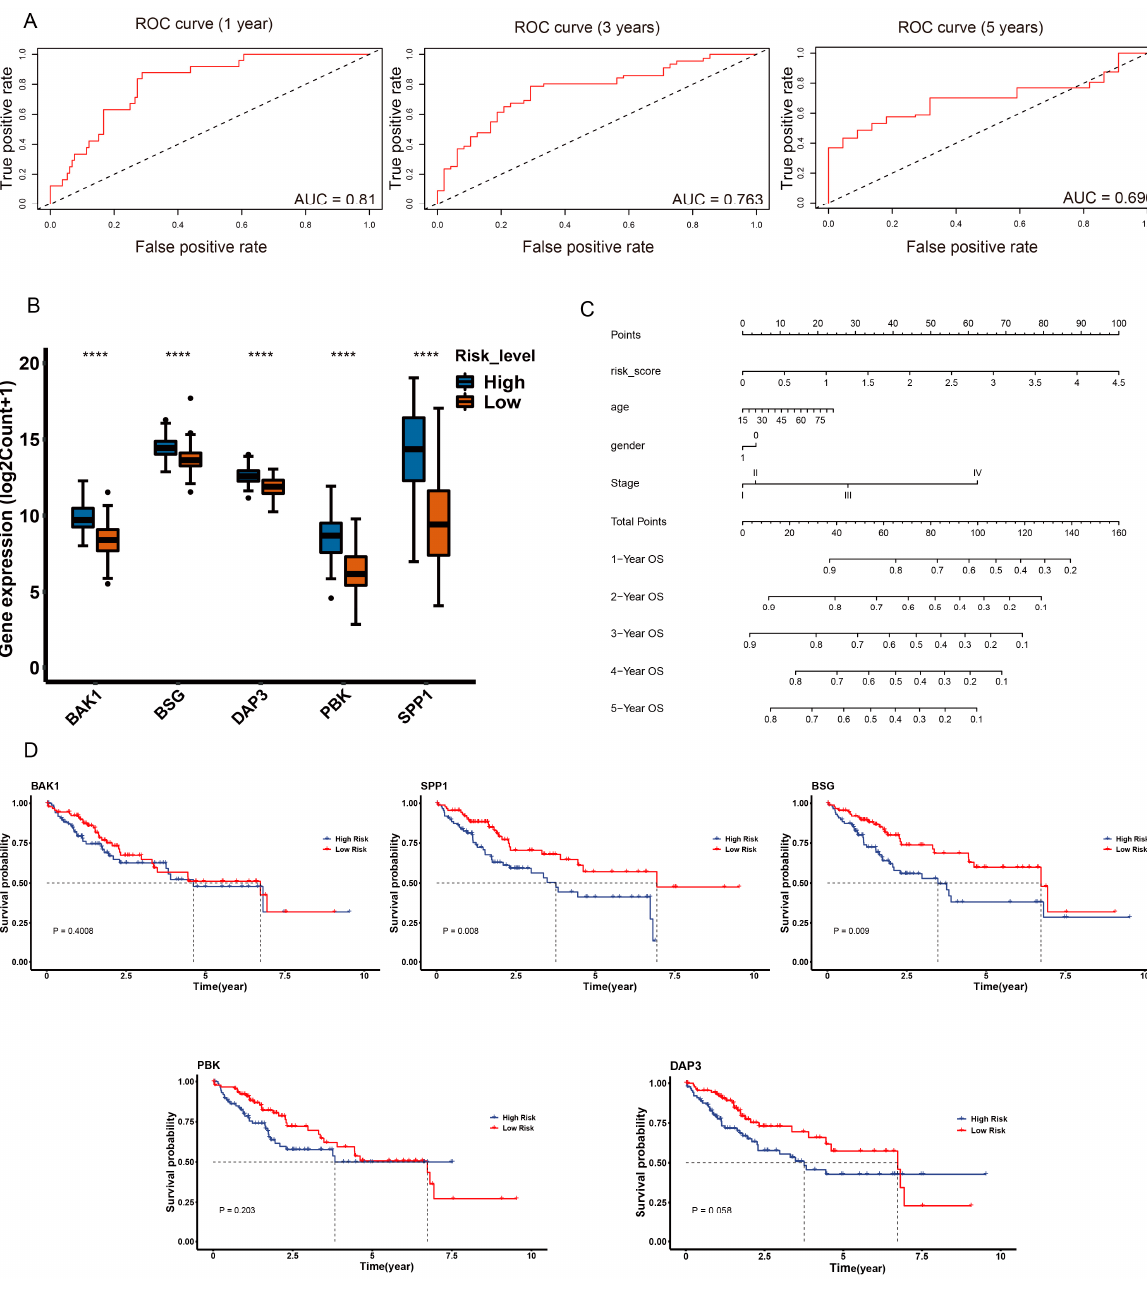
Figure 6. The performance of the prognostic risk model in the test dataset. ( A ) The time-dependent ROC curve of the performance of the prognostic model at 1, 3 and 5 years in the test dataset. The x -axis represents the false positive rate and the y -axis represents the true positive rate. The AUC value represents the area under the curve. ( B ) Boxplot of the expression of prognostic genes in the different risk groups in the test dataset. The x -axis represents the five prognostic genes and the y -axis represents the expression level of the prognostic genes. Blue represents the high-risk group and orange represents the low-risk group. ( C ) The nomogram for the prediction of overall survival in LIHC based on the risk score. ”Points” is a scoring scale for individual factors. “Total Points” is the sum of the scoring scale for each factor, such as risk score, age, gender and stage. The overall survival rate of 1–5 years was inferred according to “Total Points”. ( D ). The overall survival of the different risk groups of a single gene, including BAK1, SPP1, BSG, PBK and DAP3 in the test dataset. Blue represents patients in the high-risk group and red represents patients in the low-risk group. **** p <